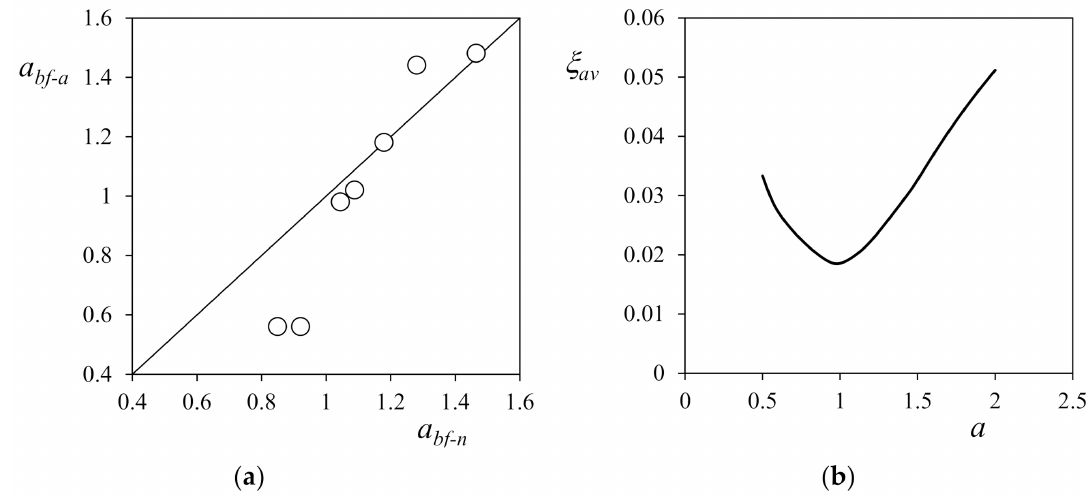
Figure 6. ( a ) Ideality factor corresponding to the best analytical fit to the 1-D/2-R equivalent circuit model, a bf-a , for the studied I-V curves, versus ideality factors obtained from the numerical fittings, a bf-n . The line corresponding to perfect correlation between both factors is shown as a reference. ( b ) Averaged non-dimensional RMSE for all analytical fittings, ξ av , versus the ideality factor, a , used in the